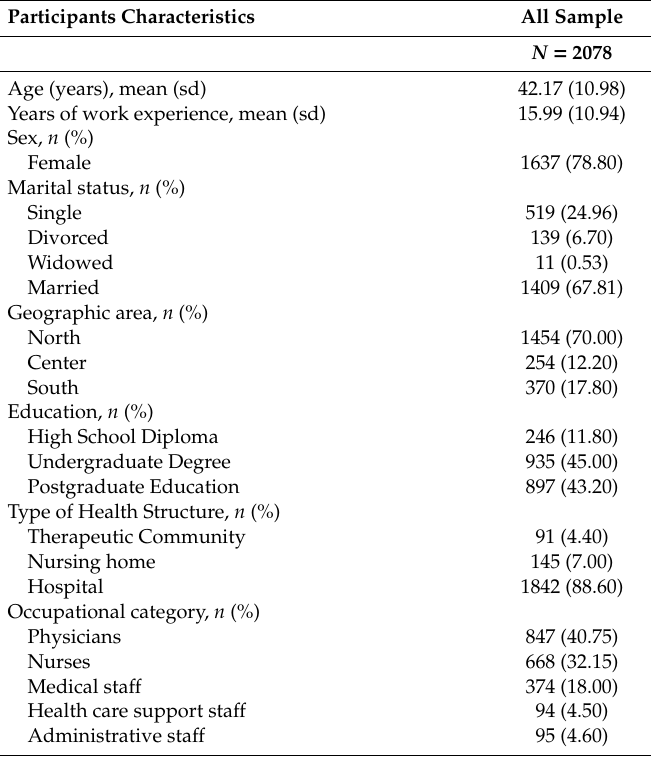
Table 1. Participants’ characteristics ( N =